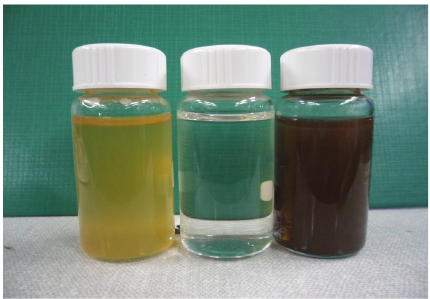
Figure 1: Apple extract, aqueous solution of 0.1M AgNO 3 , and syn- thesized AgNPs (from left to right).